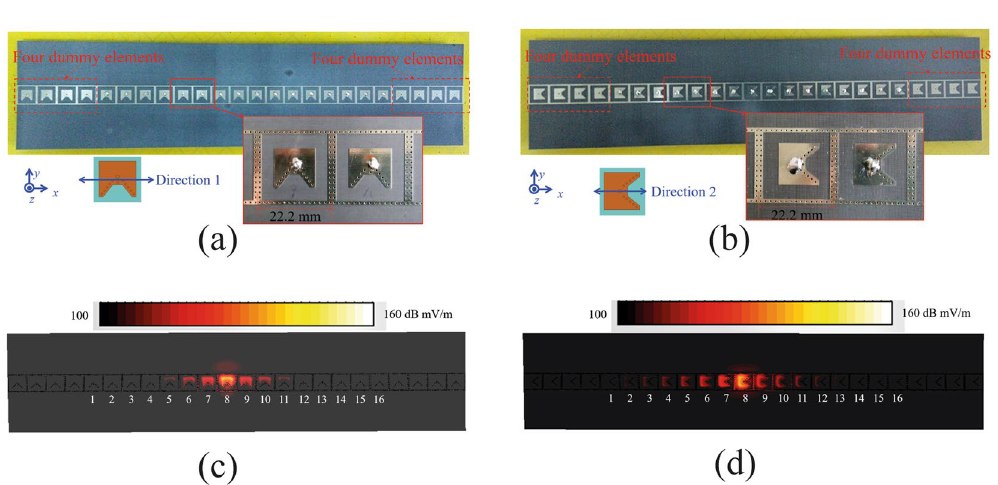
Figure 10. Two linear wide-angle scanning arrays. ( a ) A1 and ( b ) A2. A1 and A2 are respectively arranged along the length (direction 1) and width (direction 2) of the radiation patch. ( c , d ) are electric field distribution plots over ( a ) A1 and ( b ) A2 at 5.8 GHz, respectively. The plots are obtained by exciting Element 8 of the arrays, with the other elements terminated in matched loads. Low levels of coupling, below − 20 dB, are obtained beyond the second adjacent element from the excited